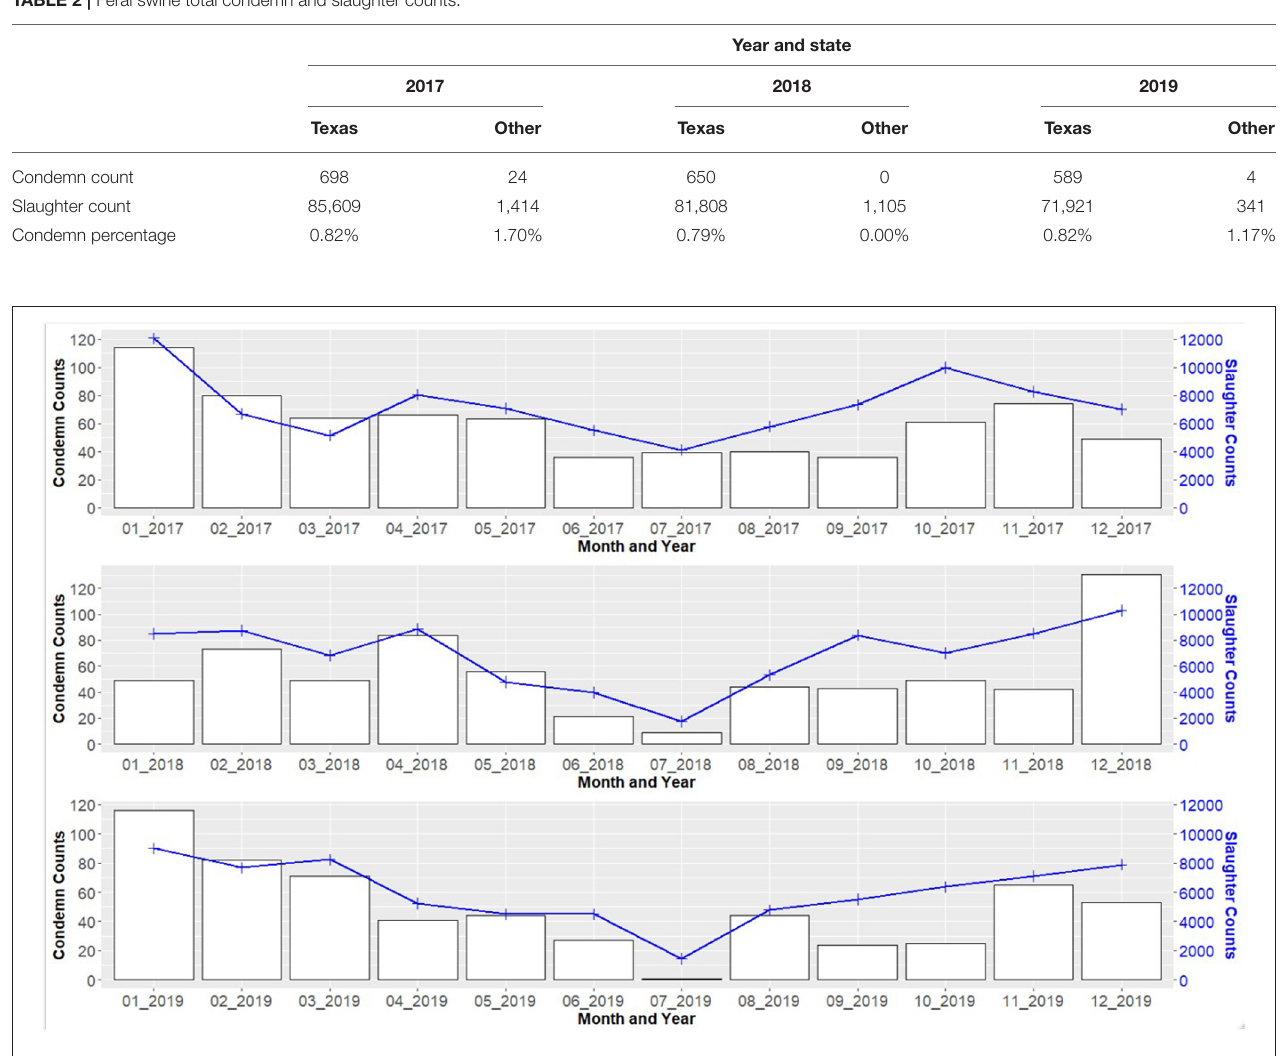
were pneumonia and abscess/pyemia. Aggregating counts appropriately was included in this exploratory phase of the